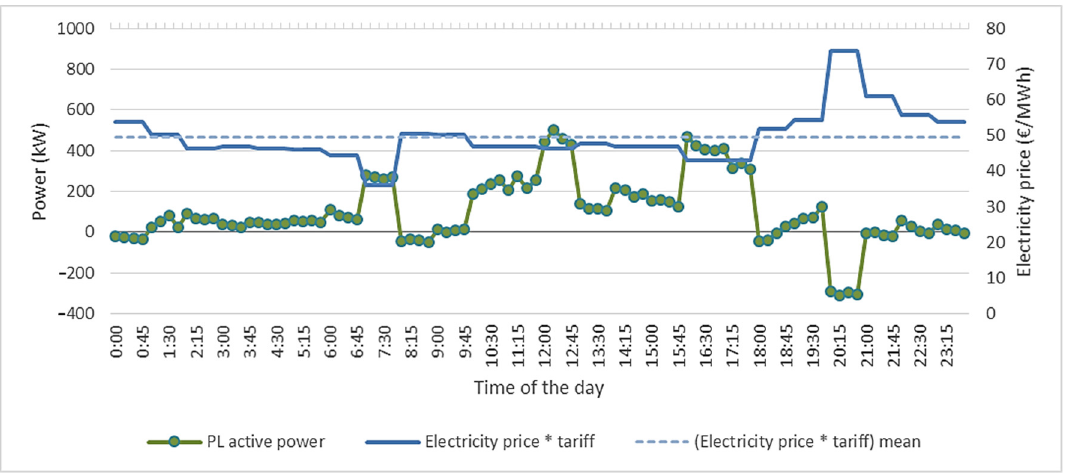
Figure 11. PL’s active power in scenario 4 and electricity price.